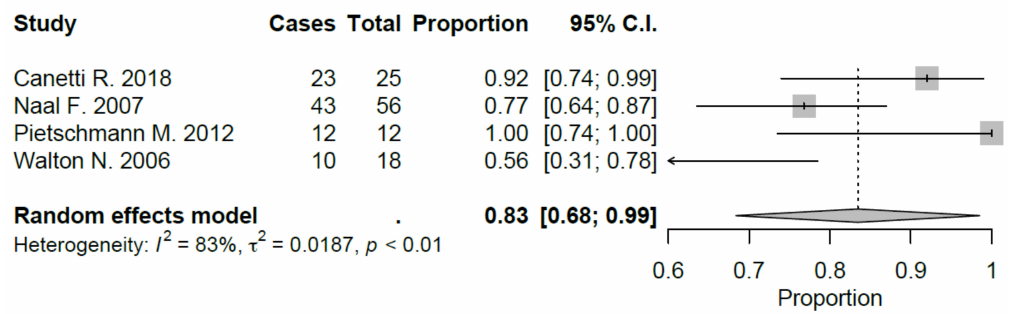
Figure 2. Overall return to sport after UKA (C.I.: Confidence Intervals).